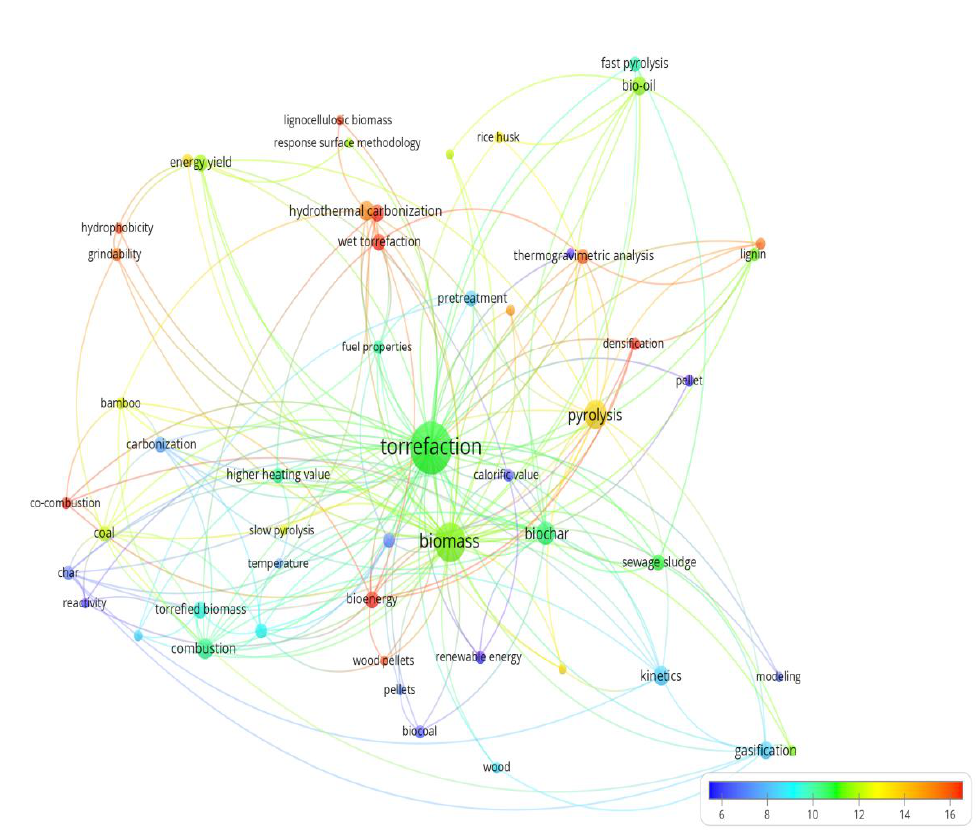
Figure 9. Map of term words with reference to citations — 2015 – 2019.